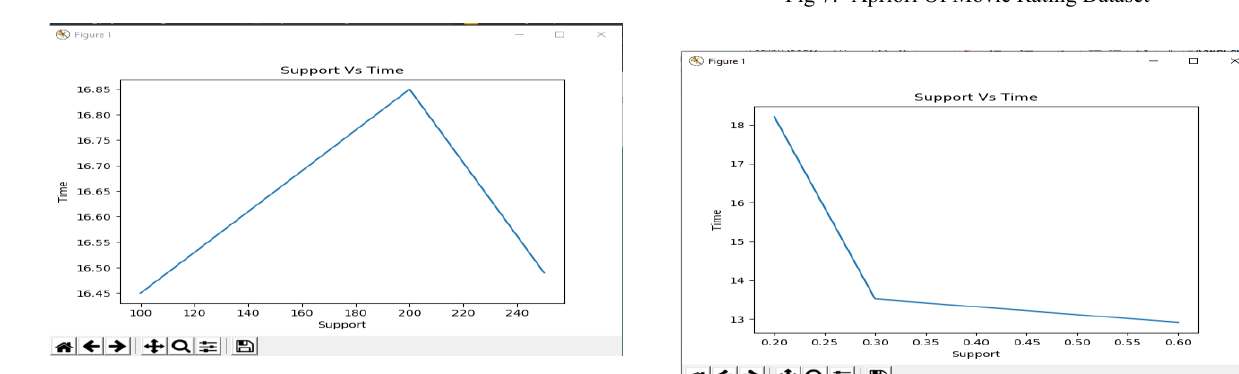
Fig 7:- Apriori Of Movie Rating Dataset